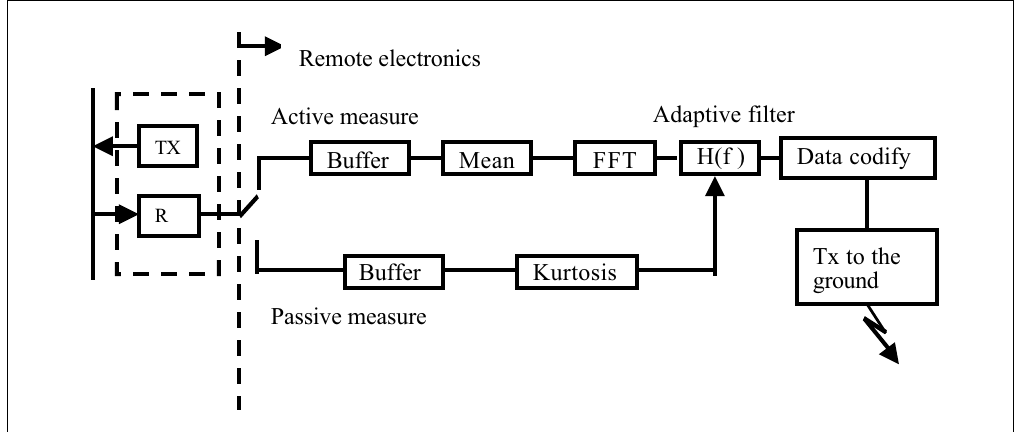
Fig. 3. Data processing block